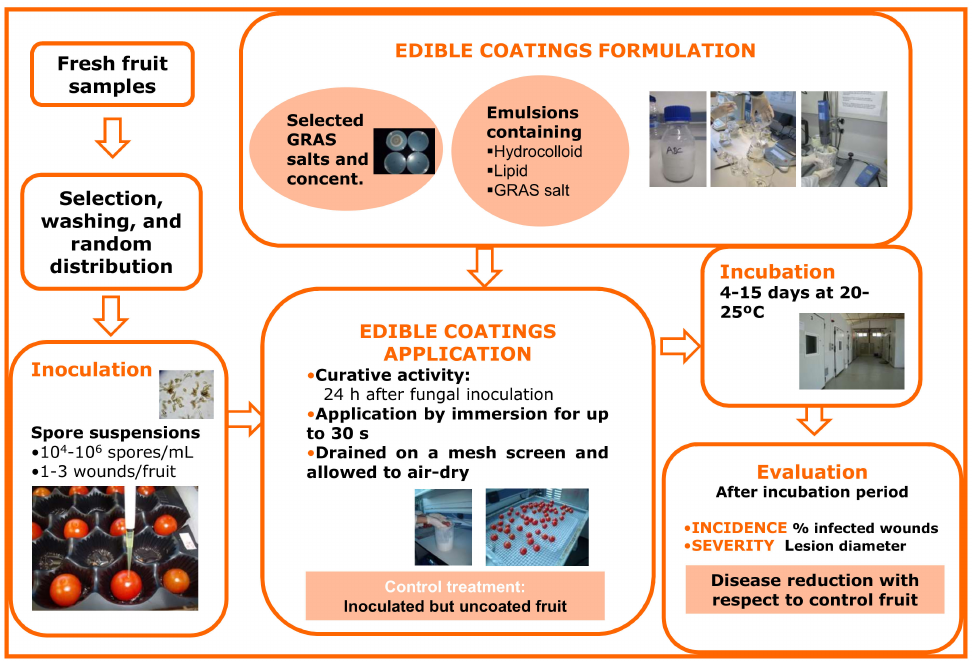
Figure 2. Methodological procedure for formulation and in vivo evaluation of the ability of edible coatings containing GRAS salts to control black spot of tomato caused by the fungus Alternaria alternata